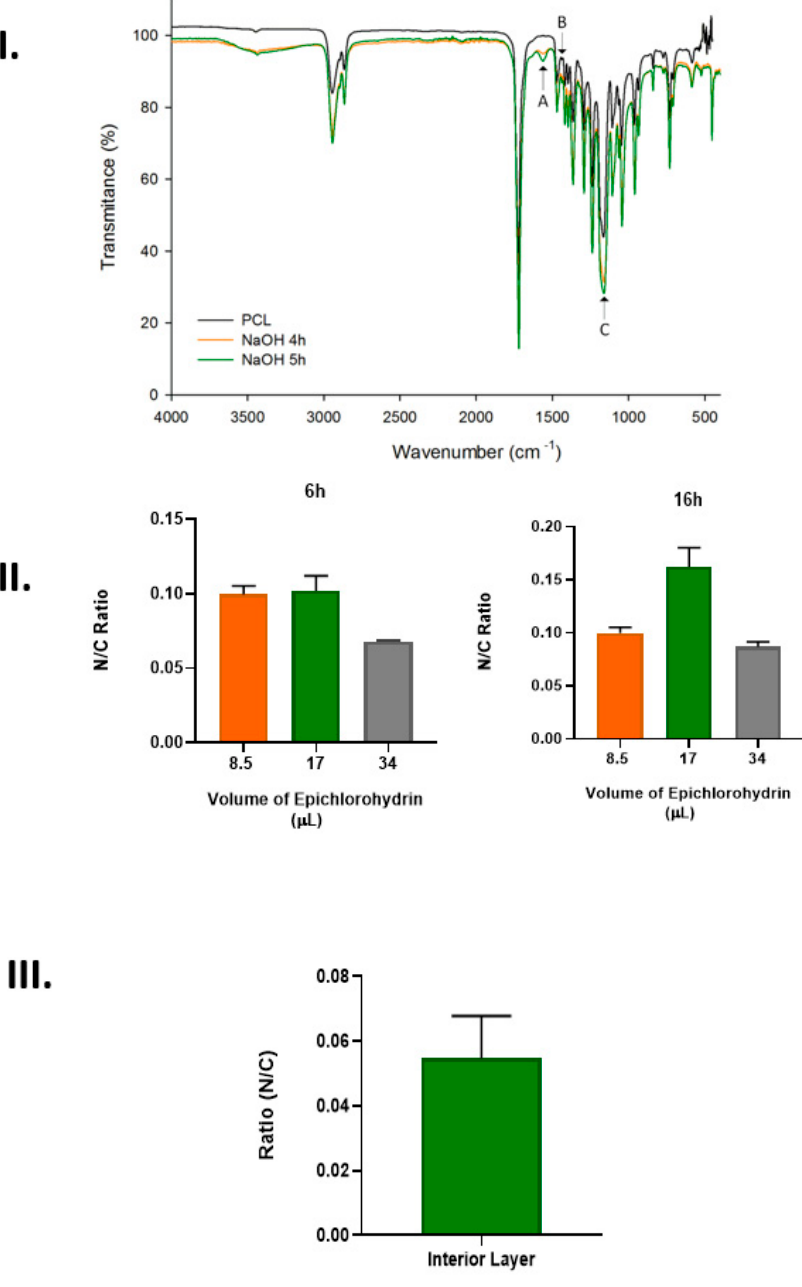
Figure 2. Assessment of the arginine’s immobilization on the 3D-printed chromatographic support. ( I ) FTIR analysis of the 3D-printed PCL after 4 h and 5 h of contact with 3 M of NaOH—A and B could represent ester bond cleavage, demonstrating the PCL modification and C represents the peak with where can be visualized the available anchoring sites for epoxy group bonding; ( II ) EDX analysis of the PCL surface exposed to different amounts of epichlorohydrin for 6 and 16 h; ( III ) EDX analysis of the internal layer of the 3D-Printed chromatographic structure after the immobilization process ( n =